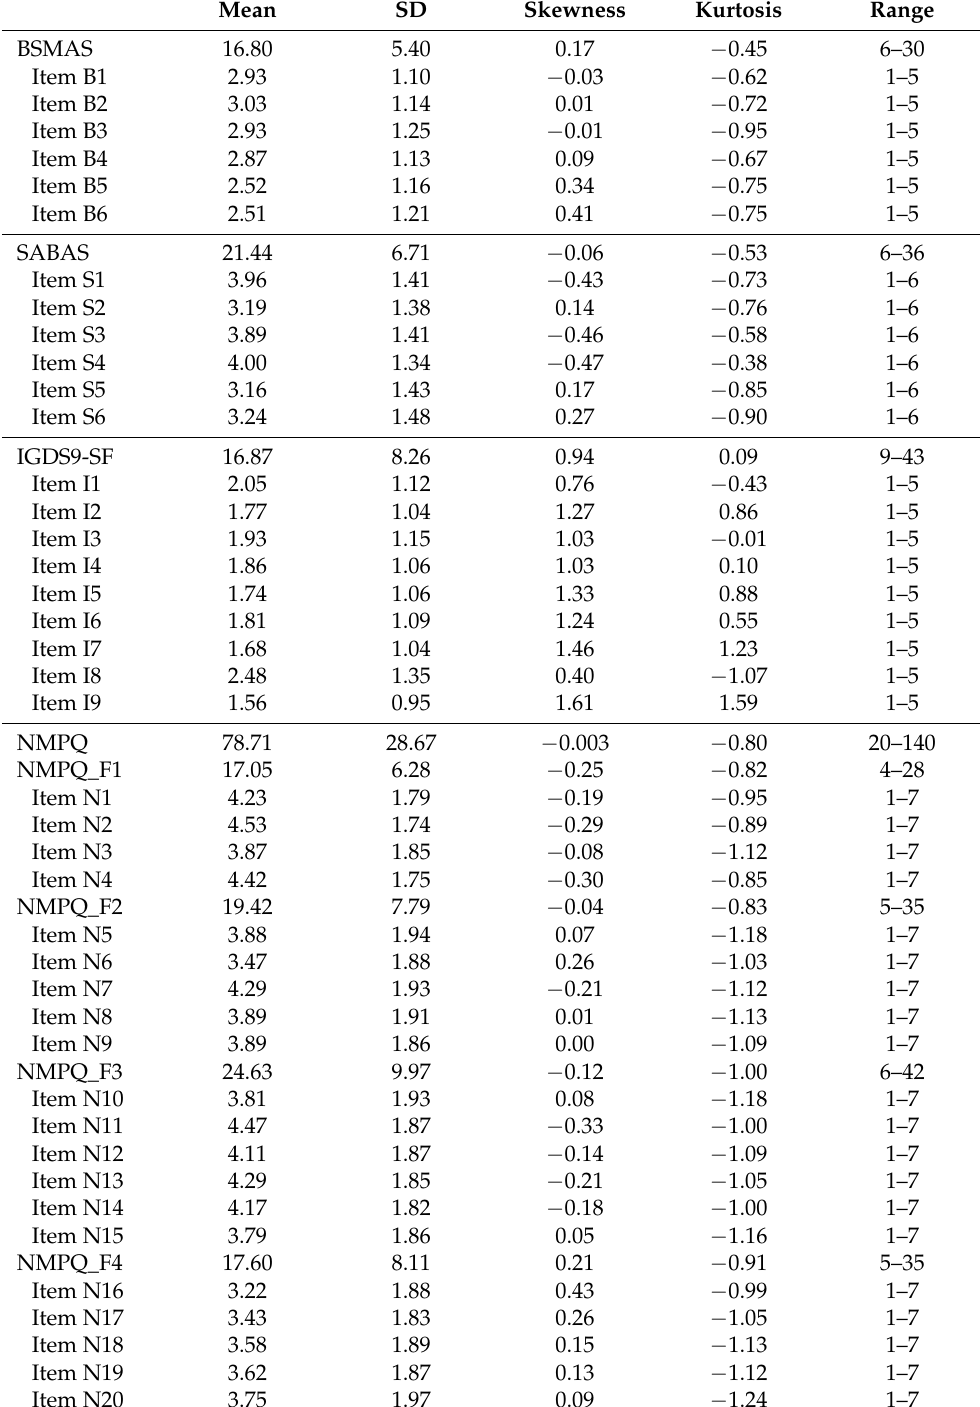
Table 2. Score distributions for the items of the internet-related